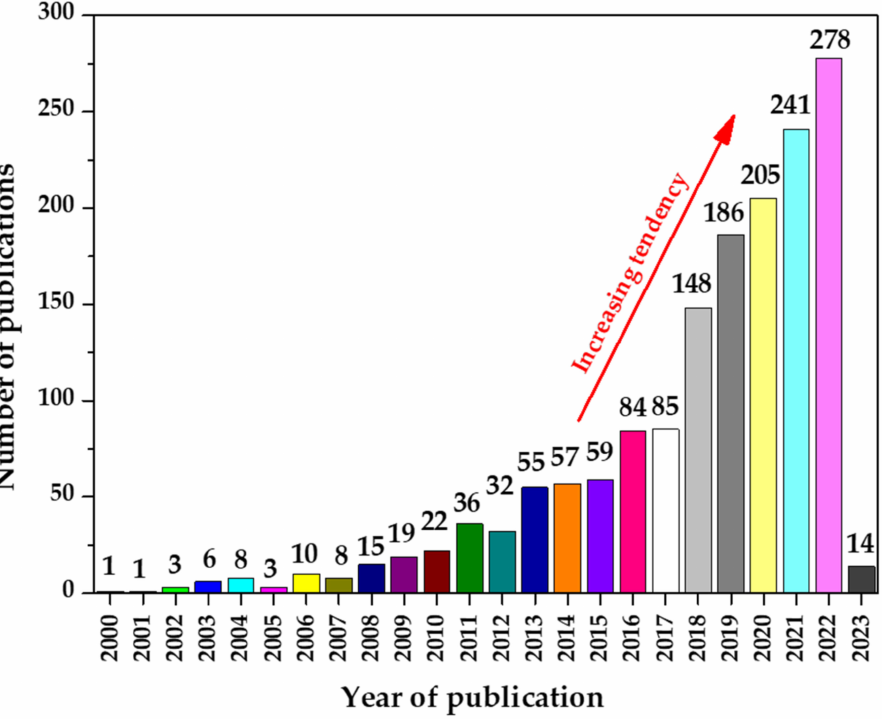
Figure 1. Number of publications with the words “alginate adsorbents” based on the Scopus database score (data from 1 December